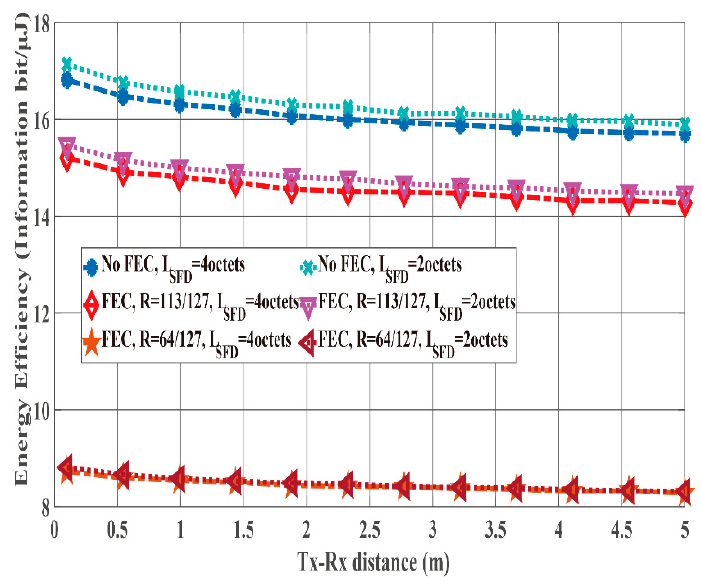
Figure 19. Energy efficiency performance as a function of the Tx-Rx distance. Case with an SFD ( L SFD = 2 octets and 4 octets).